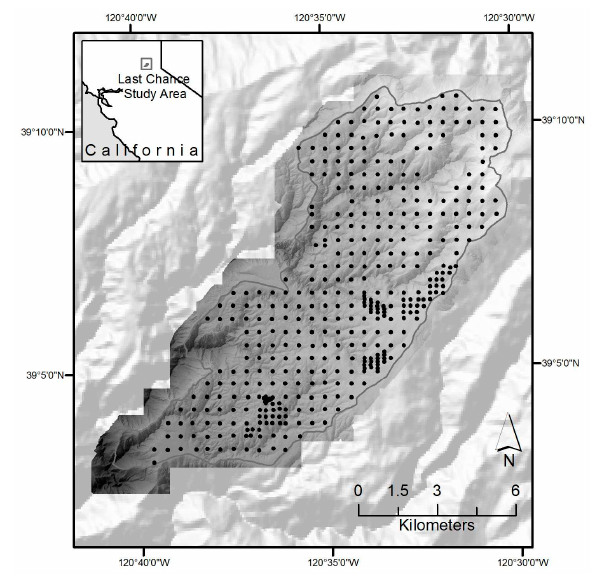
Figure 1. Last Chance Study Area in the Tahoe National Forest with field plot network.